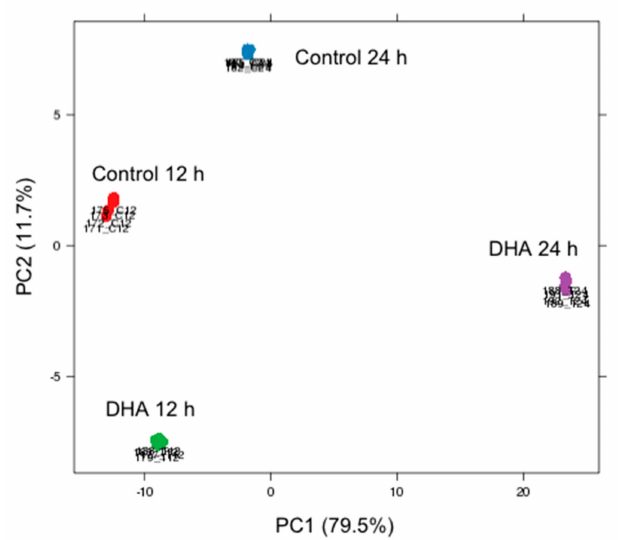
Figure 1. Principal component analysis (PCA) of RNA-seq samples. PCA of samples analyzed in quadruplicate. PC1 (79.5%) shows a very significant di ff erence between the samples treated with DHA for 24 h (violet spots) versus all other samples. PC2 (11.7%) discriminates control samples (red and blue spots) from treated samples (green and violet spots). These two axes explain 91.2% of the data variability, with a very good intra-group